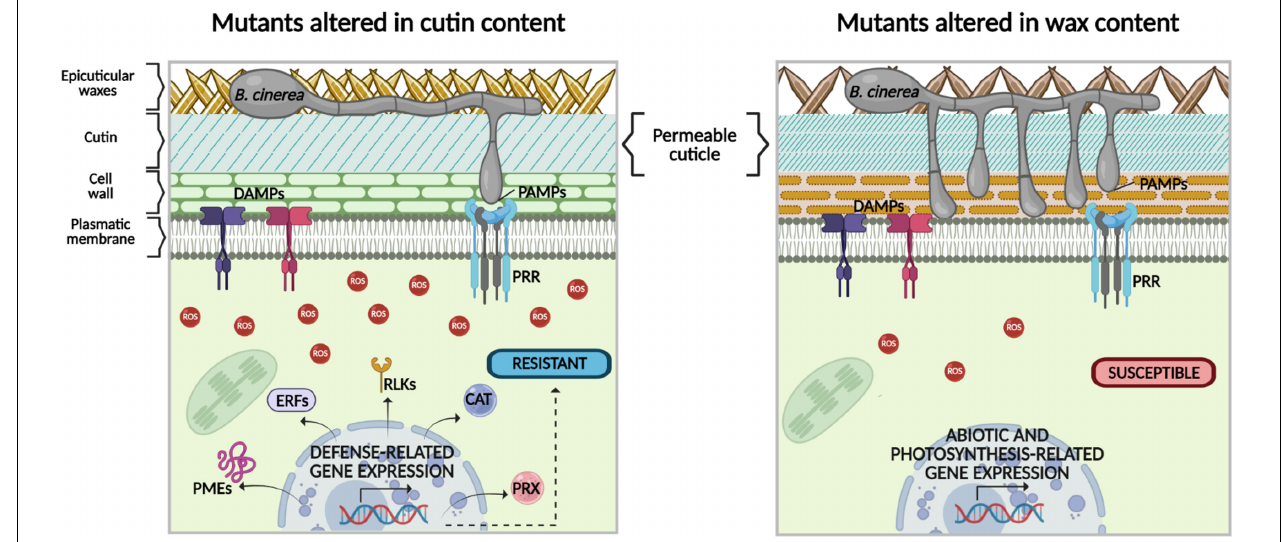
FIGURE 9 | Hypothetical model of the role of cuticular components cutin and wax in differential response to the necrotrophic fungus B. cinerea . In previous studies, a direct relationship between increased permeability in cutin mutants and resistance to B. cinerea has been proposed. However, our data show that despite both cuticular mutants having enhanced cuticular permeability, compared with the WT plants, only mutants with altered cutin content show resistance to B. cinerea . This phenotype could be explained as follows: (1) in the cutin mutants, once plant plasma membrane-localized receptors recognize pathogen-/damage-associated molecular patterns (PAMPs/DAMPs) a more intense ROS production is observed, compared with mutants with altered wax content. (2) During cutin mutant- B. cinerea interaction, defense-related signaling pathways are triggered, which are different from canonical immune ones, such as expression genes encoding catalases ( CAT3 ) and peroxidases ( PRX ), as well as LRR-receptor-like kinases ( RLK5, RLK7, RLP30 ), transcription factors ( ERF108 and ERF113 ), and genes involved in the remodeling of the cell wall, such as PMEs . (3) In contrast, according to our data, in the mutants with altered wax content, ROS production is not enough to effectively prevent B. cinerea colonization. In these mutants, other secondary signals might be activated to control the expression of genes related to abiotic stimuli, instead of the expression of defense-related genes (the image was designed using bioRENDER application, https://biorender.com/).